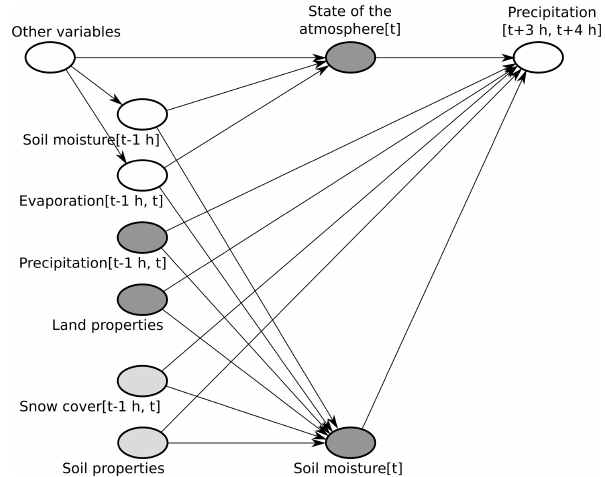
Figure 5. Causal graph in the example of soil-moisture– precipitation coupling. The dark grey nodes represent the chosen in- put variables, while light grey nodes represent variables that are ig- nored in our analysis (see text). Land properties comprise the time- independent variables topography, land–sea mask, and fractions of high and low vegetation cover. The state of the atmosphere at time t is represented by temperature and dew point temperature at 2m height at time t , as well as wind at 100m height at time t . In addi- tion to these variables, we included short- and long-wave radiation at the land surface at time t . Note that the depicted causal graph only includes nodes and edges that are relevant for the adjustment criteria from Sect. 2.1.2 (e.g., no edge from “other variables” to P [ t − 1h ,t ] , and no nodes on the causal path from SM [ t ] to P [ t + 3h ,t + 4h ] , such as evaporation [ t,t + 3h ]